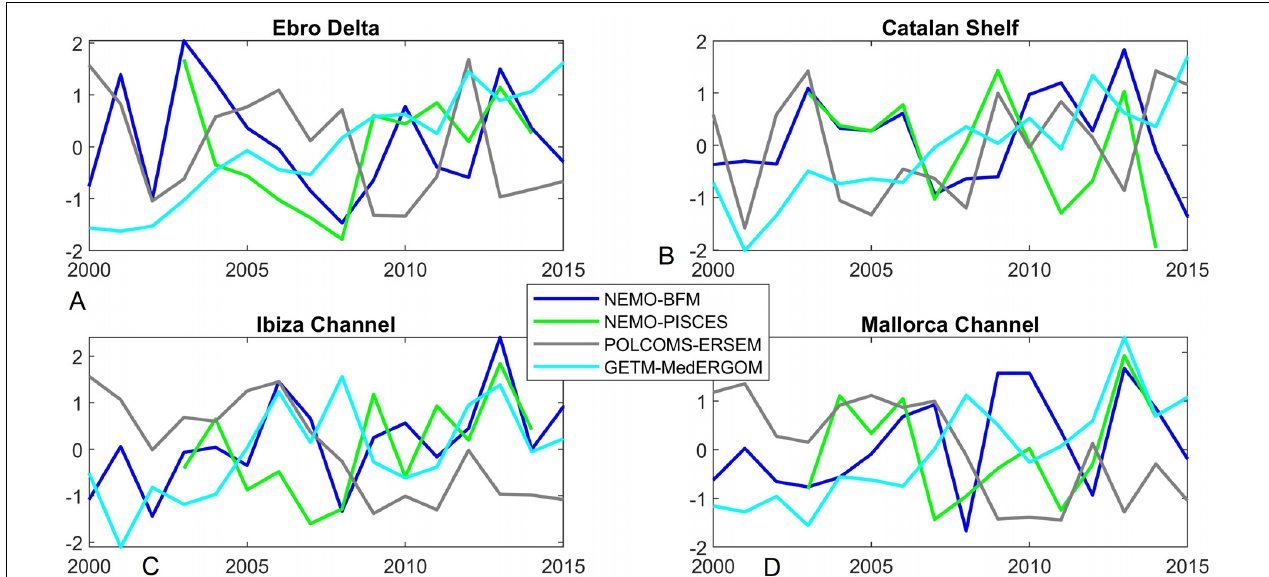
FIGURE 13 | Normalized anomalies (z-scores) for integrated chlorophyll- a (0–100 m) time series for the different chosen areas. Each series of annual averages were normalized using the whole period average and standard deviation. (A) Ebro Delta; (B) Catalan Shelf, (C) Ibiza Channel, and (D) Mallorca Channel.